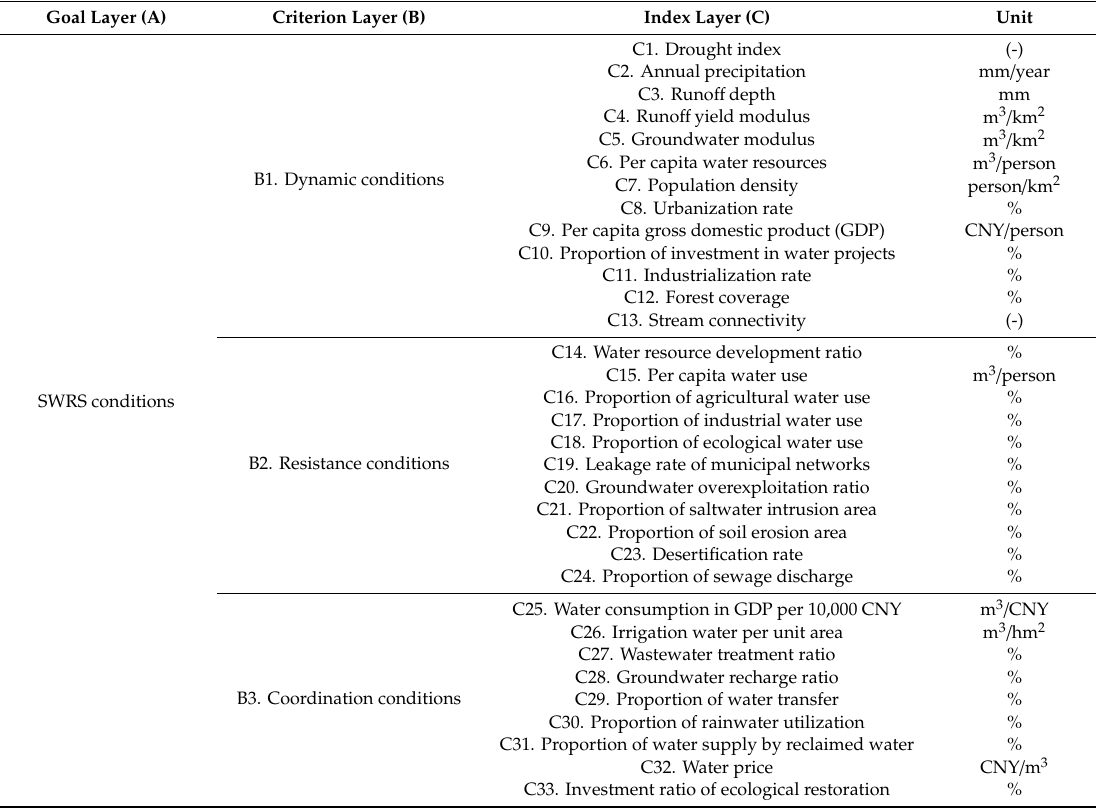
Table 1. Universal evaluation indicator system for an SWRS.